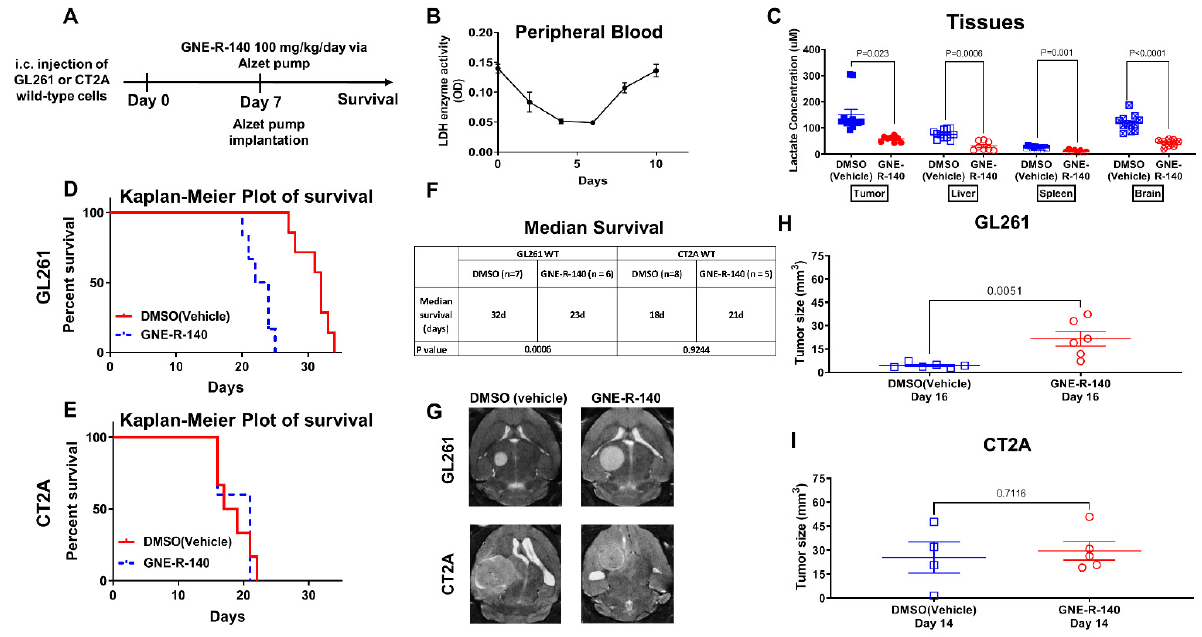
Figure 7. GNE-R-140 treatment effects on GL261 and CT2A i.c. tumors. Outline of the experimental protocol for evaluating the LDHA inhibitor (GNE-R-140) ( A ). Time course of GNE-R-140 treatment effect on venous blood (RBC) LDH enzyme activity ( B ). Ex vivo intracellular lactate concentration from GL261 tumors and tissue extracted at day 10, comparing GNE-R-140 treatment vs. vehicle (DMSO) control treatment ( C ). Kaplan–Meier plots of animal survival following i.c. implantation of WT GL261 and CT2A tumors and treatment ( D , E ). Median animal survival time is shown in the table ( F ). Representative T2-weighted MRI images of GL261 tumors (at day 16 post-implantation), and CT2A tumors (at day 14 post-implantation); 7 days after initiating GNE-R140 treatment ( G ). Comparison of MRI-measured tumor size on indicated days for GL261 ( H ) and CT2A ( I ) wild-type tumors following GNE-R-140 and vehicle treatment.